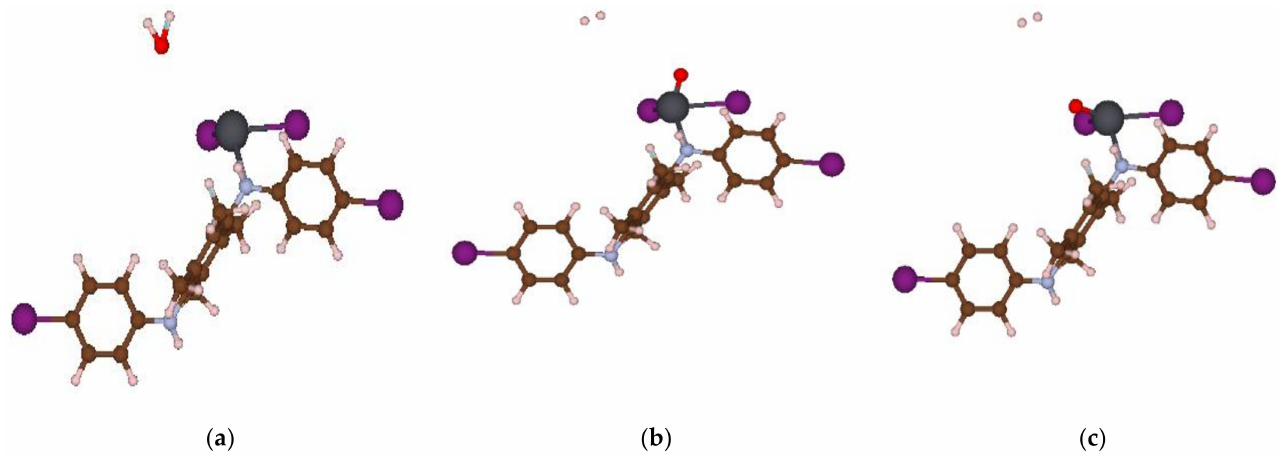
Figure 10. Atomic configurations of the reactant (R)—( a ) transition state (TS)—( b ) and product (P)—( c ) along the reaction line for the H 2 O splitting by the PbI 2